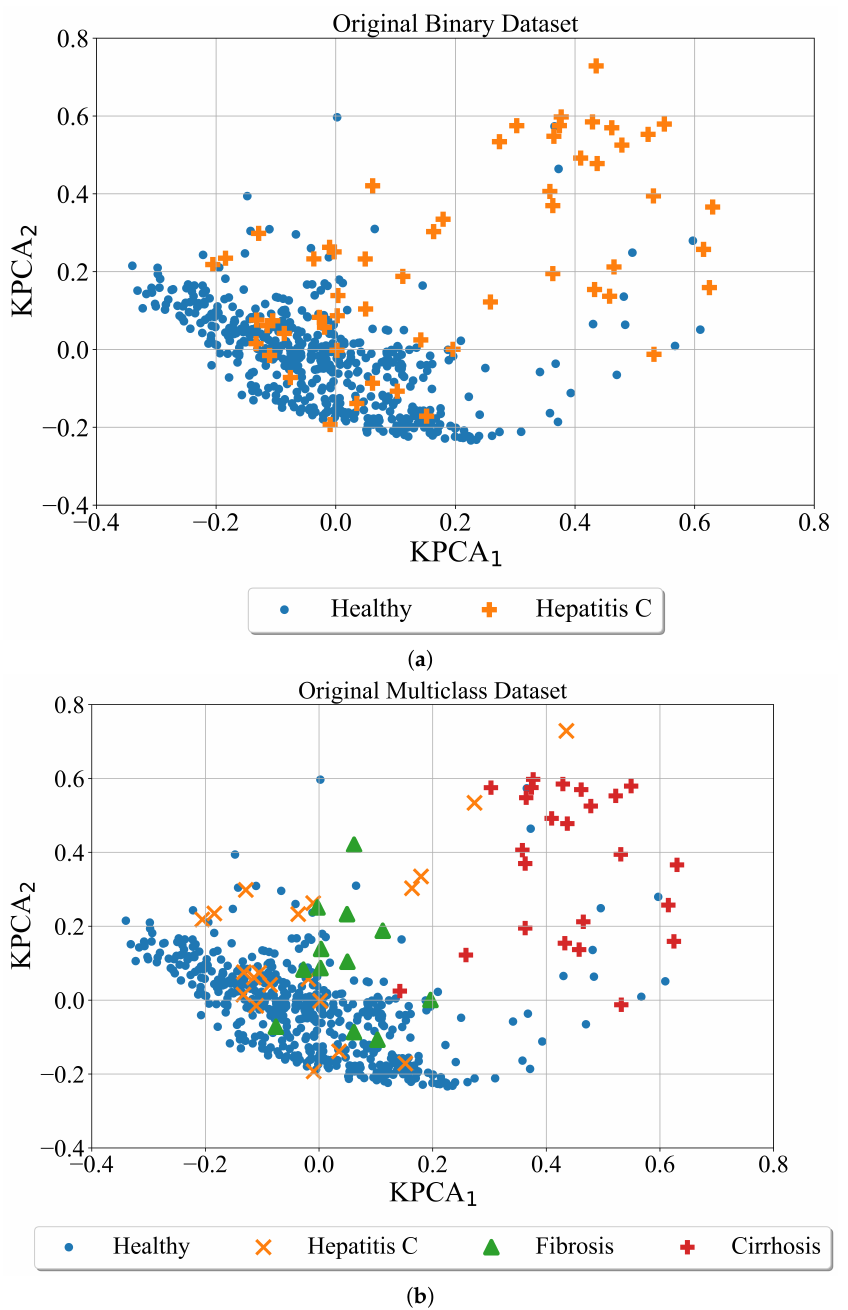
Figure 4. The results of Kernel PCA application on original binary and multiclass datasets. ( a ) Binary scatter plot; ( b ) Multiclass scatter